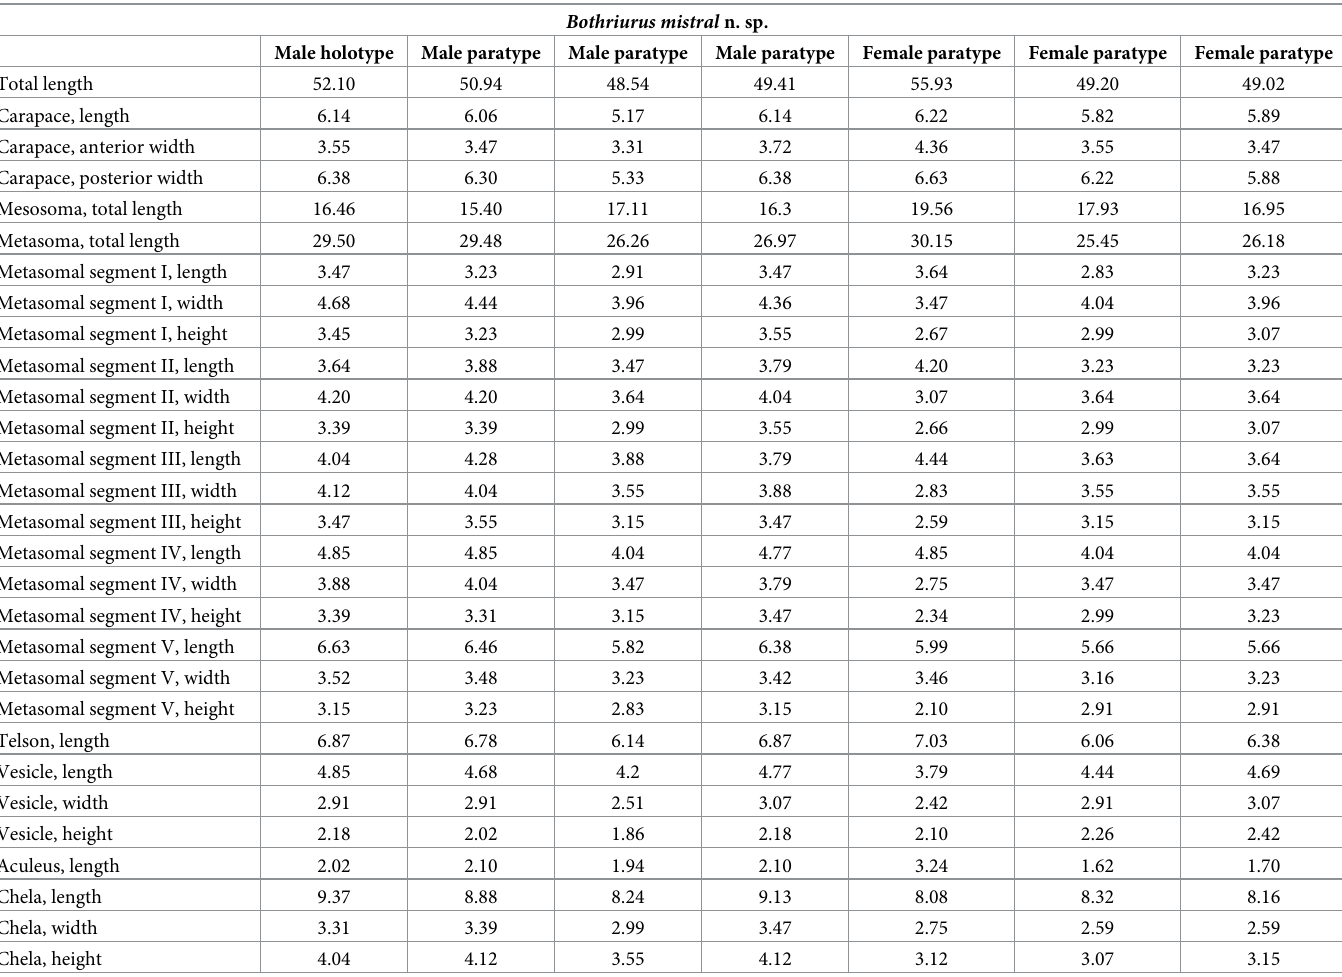
Table 1. Measurements (mm) of Bothriurus mistral n.